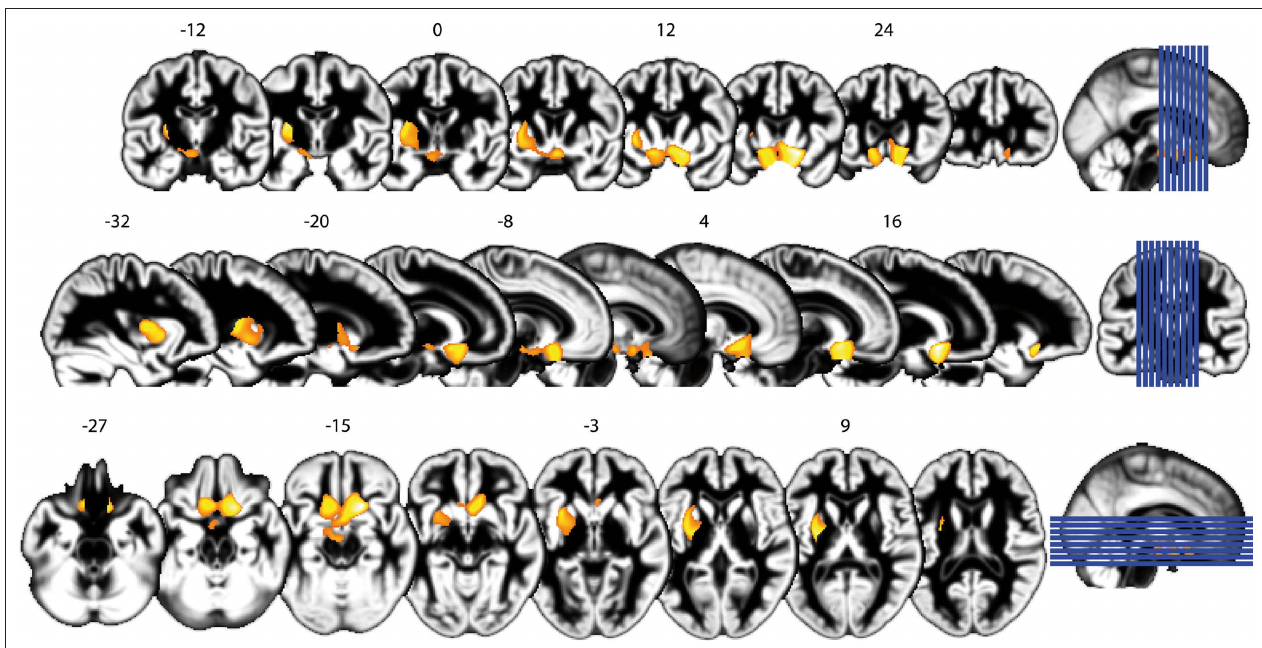
indicate slice location in MNI coordinates. The position of the slices in relation to the whole brain is indicated visually on the right (blue lines). Middle row: sagittal slices, conventions as above. Bottom row: axial slices, conventions as above.